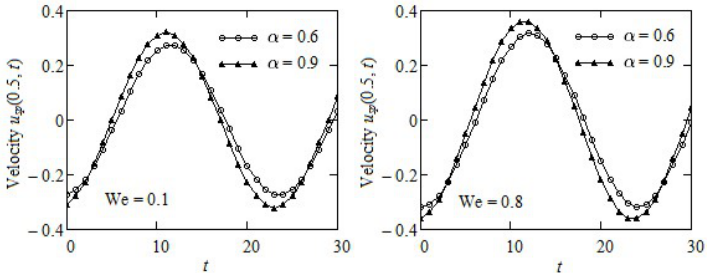
Figure 6. Profiles of velocities u sp ( y , t ) for Re = 100, ω = π /12, α = 0.6 and α = 0.9 and two values of Weissenberg number